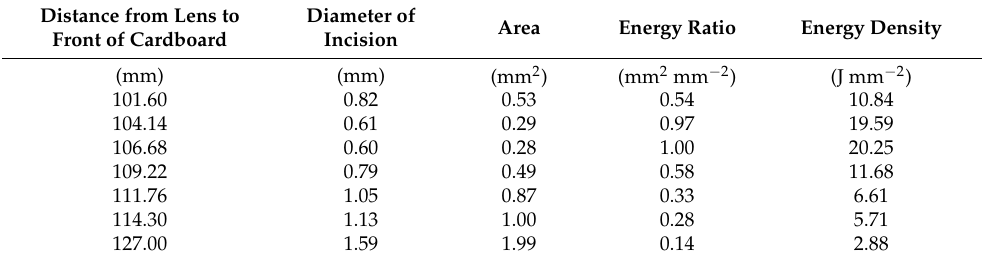
Table 1. CO 2 laser energy density at varying distances from the 100 mm lens for 100% duty cycle (un-modulated excitation voltage).